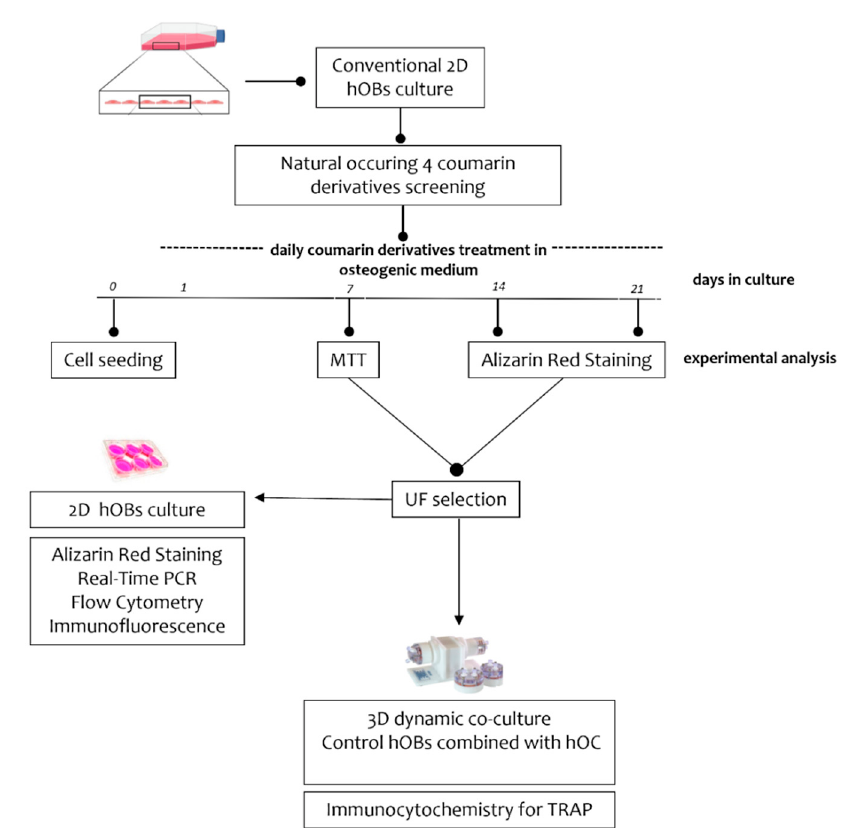
Figure 1. Experimental plan: hOBs were treated or not with 4 different coumarin derivatives—umbelliferon (UF), 7-Isopentenyloxycoumarin (7-ISO), aurapten (AU), or umbelliprenin (UP)—for 7, 14 or 21 days. After a screening by performing MTT assay and Alizarin Red staining, only UF was selected for further analysis. The effects of UF on bone mineralization were evaluated by performing Alizarin Red staining, real-time PCR, flow cytometry, and immunofluorescence analyses. In addition, TRAP staining was performed in a 3D co-culture system composed of control hOBs and hOCs in order to reproduce the bone remodeling unit under bone loss conditions in vitro.